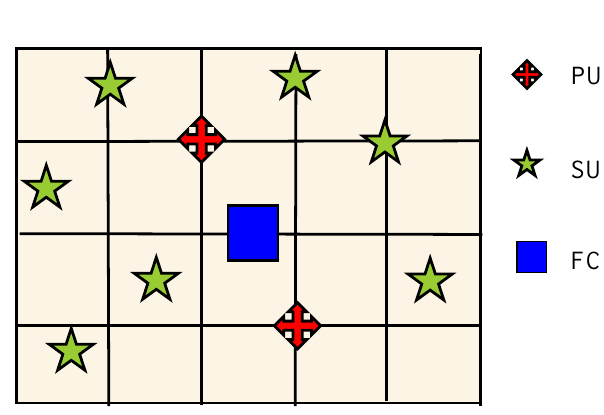
Figure 1. System model demonstrating the positioning of PU, SU and FC